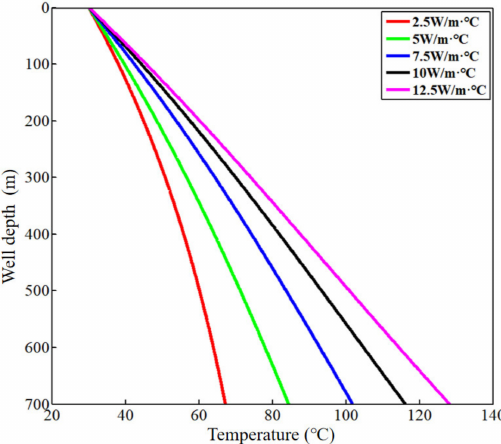
Figure 15. Temperature distribution of produced gas using different thermal conductivities of production tubing.